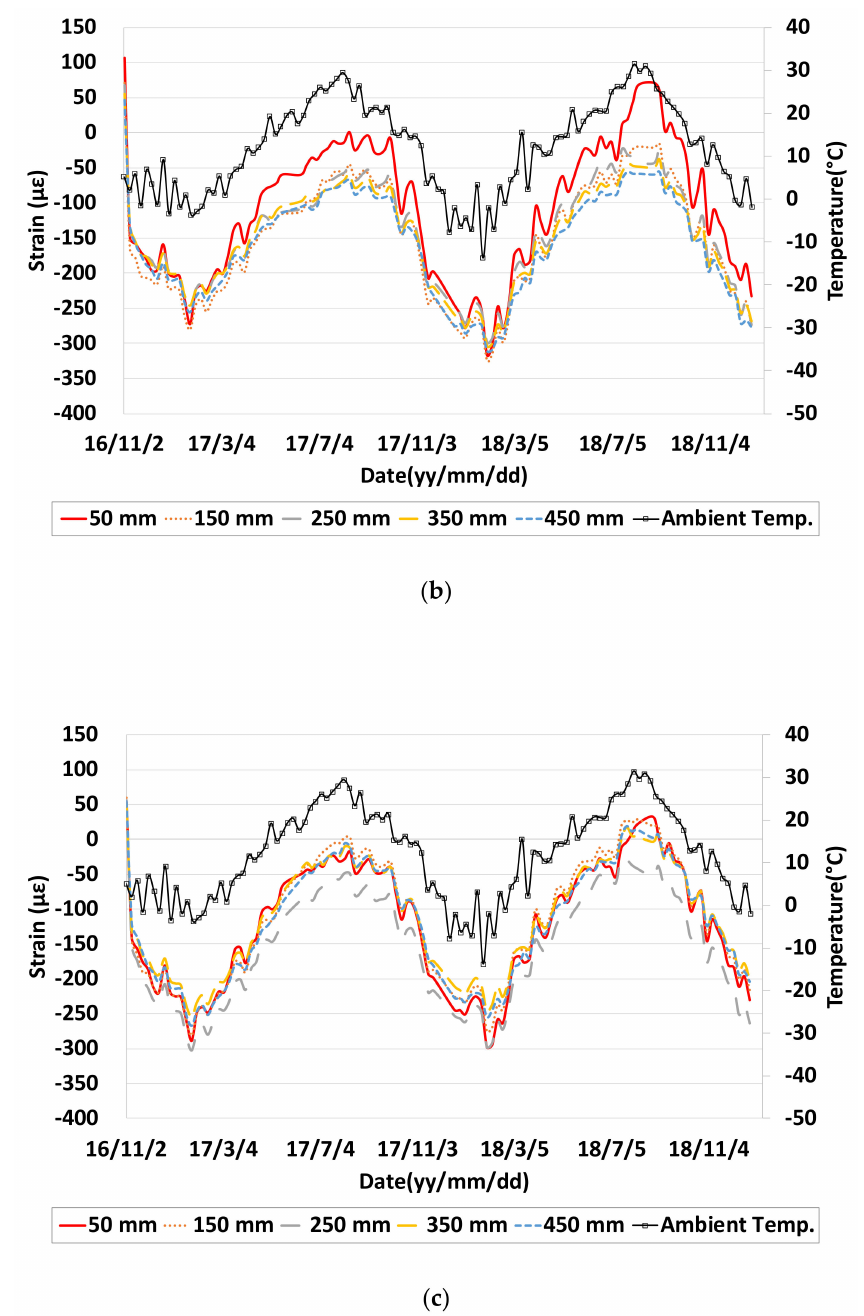
Figure 16. Real strain according to the slab depth over a two-year period: ( a ) corner, ( b ) mid-edge, and ( c )